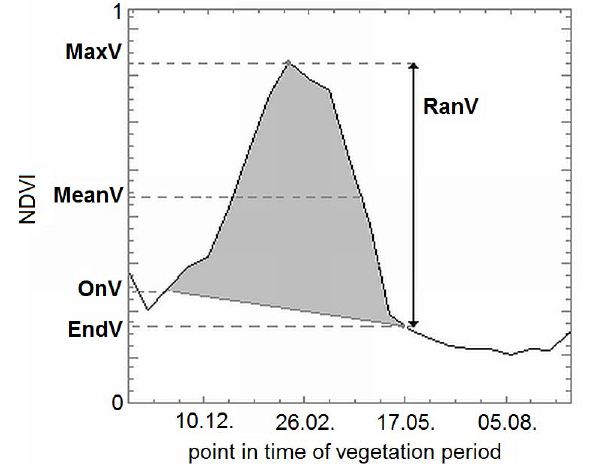
Fig. 4. Hierarchically structured binary decision tree classifier